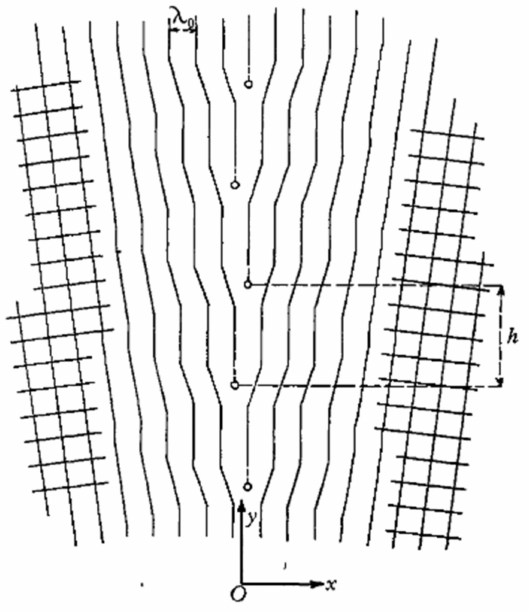
Figure 1. Schematic diagram of a transition surface between two domains, formed by a set of parallel lines of edge dislocations, all situated in the plane x = 0 [40]. Reprinted from Proceedings of the Physical Society (1926–1948), Geometrical considerations concerning the structural irregularities to be assumed in a crystal, J. M. Burgers, Proc. Phys. Soc. 1940, 52, 23. © IOP Publishing. Reproduced with permission. All rights